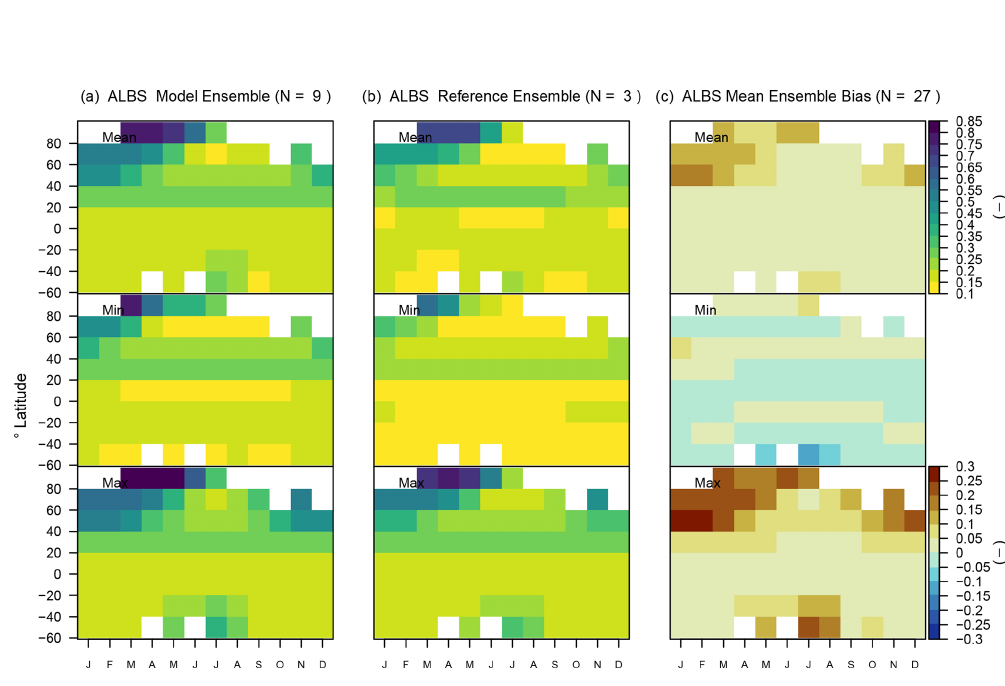
Figure A6. Same as in Fig. 8 but for surface albedo.